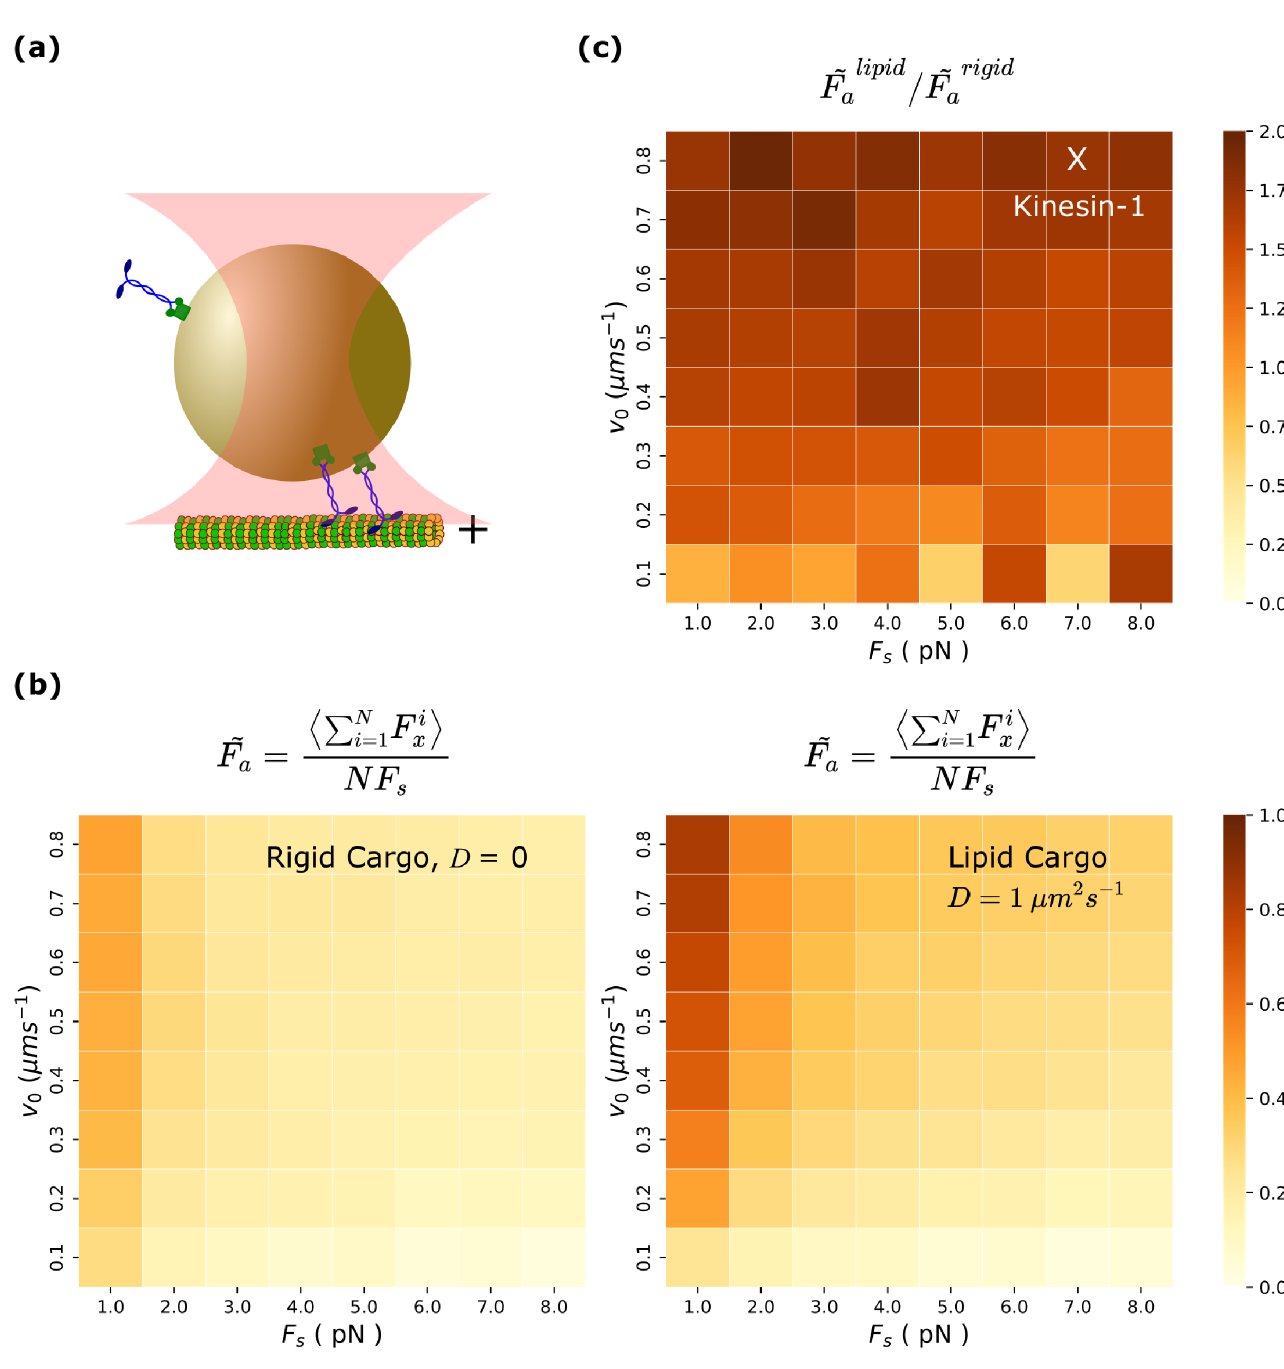
) in rigid (left) and lipid (right) cargo. (c) Ratio of ~ F s